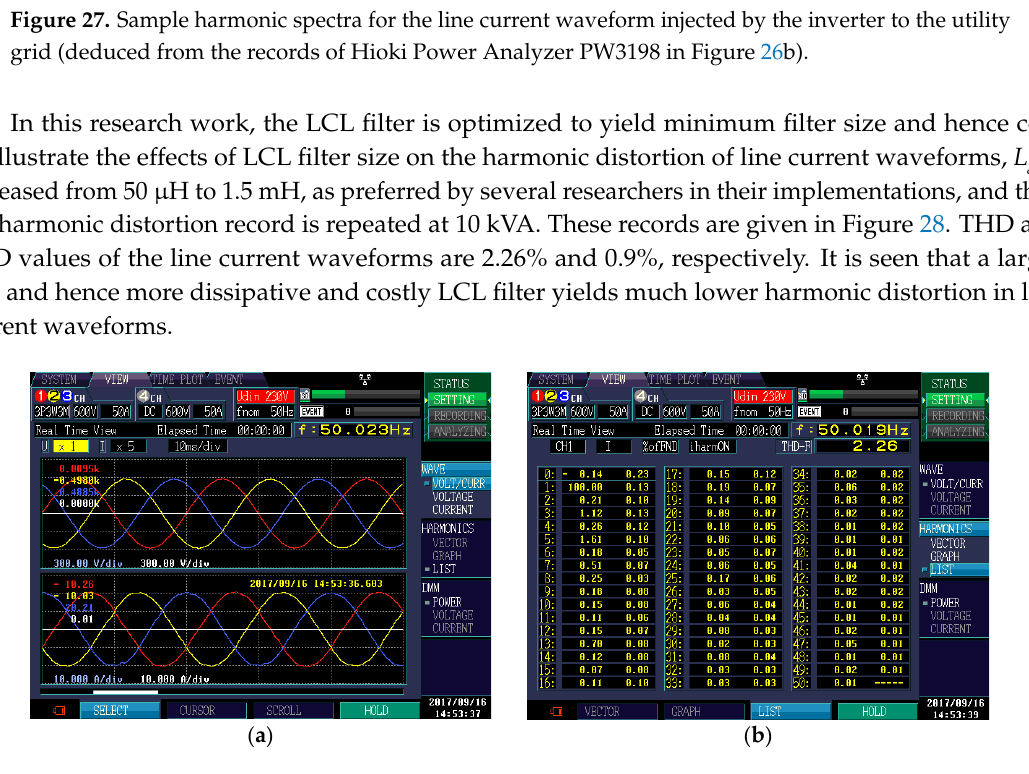
Figure 28. Snapshots of grid-side electrical quantities captured from the experimental set-up in Figure 1b by Hioki Power Analyzer PW3198 at P o = 10 kW for L g = 1.5 mH: ( a ) line-to-line voltage and line current waveforms; and ( b ) harmonic content of line current waveforms.